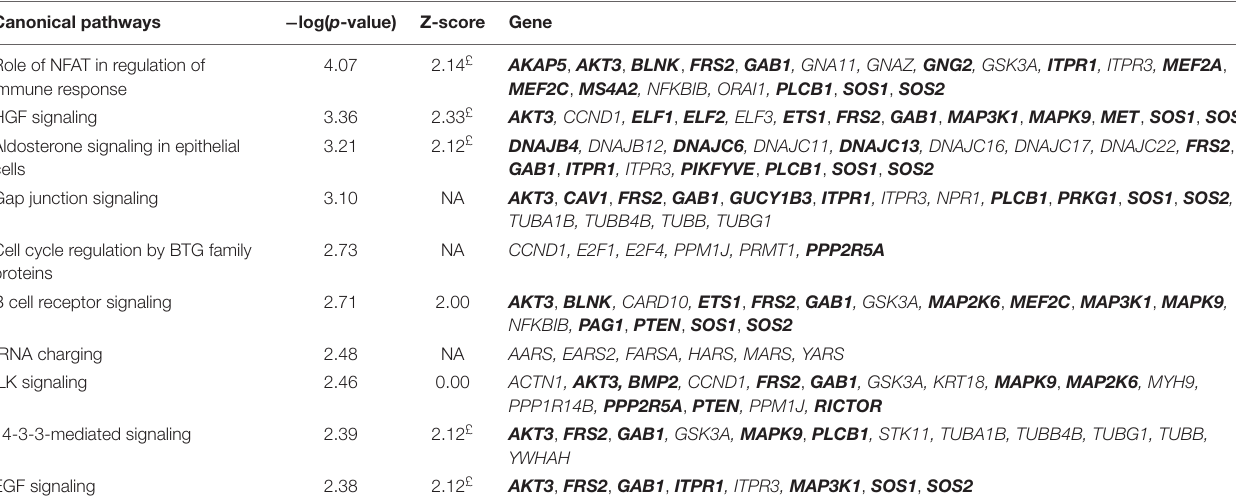
TABLE 4 | Most significantly enriched canonical signaling pathways identified in liver samples of feed efficiency (FE)-divergent pigs. Canonical pathways − log( p -value) Z-score